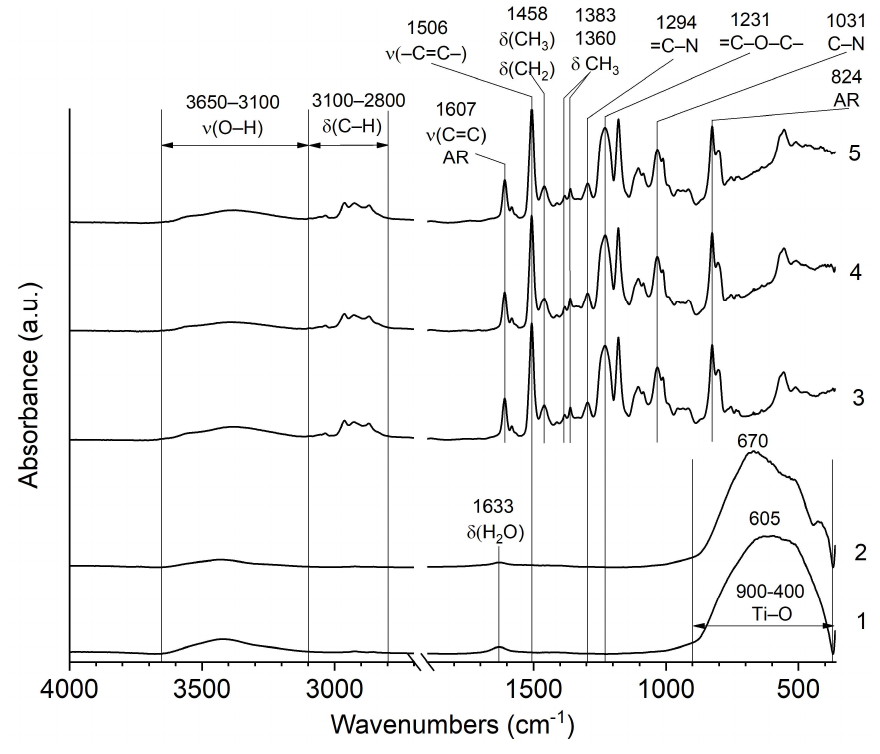
Figure 6. ATR-FTIR spectra: 1—TiO 2 ( d av = 46 nm); 2—TiO 2 ( d av = 100 nm); 3—cured epoxy; 4— TiO 2 /EP of System I (4 wt. % TiO 2 ); and 5—TiO 2 /EP of System II (4 wt. % TiO 2 ). AR denotes aromatic groups, and =C–N denotes conjugated C–N bonds.